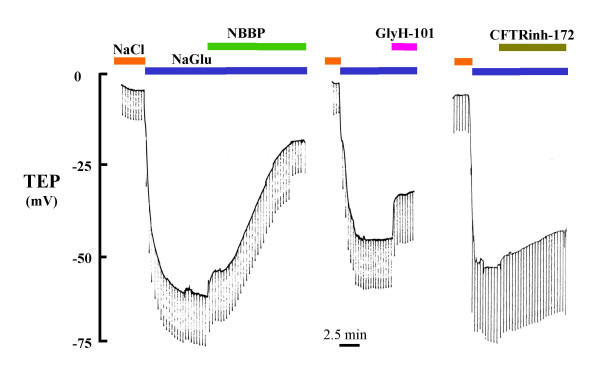
Effect of Cl- conductance inhibitors on TEP. In the absence of luminal Cl- (Gluconate substitution), two new inhibitors GlyH-101 (50 μM) and CFTRInh-172 (5 μM, re: A. Verkman) showed at least partial inhibition of the Cl-:Gluconate anion diffusion potential. NPPB (100 μM) seemed to be the most effective inhibitor in terms of depolarizing the TEP.